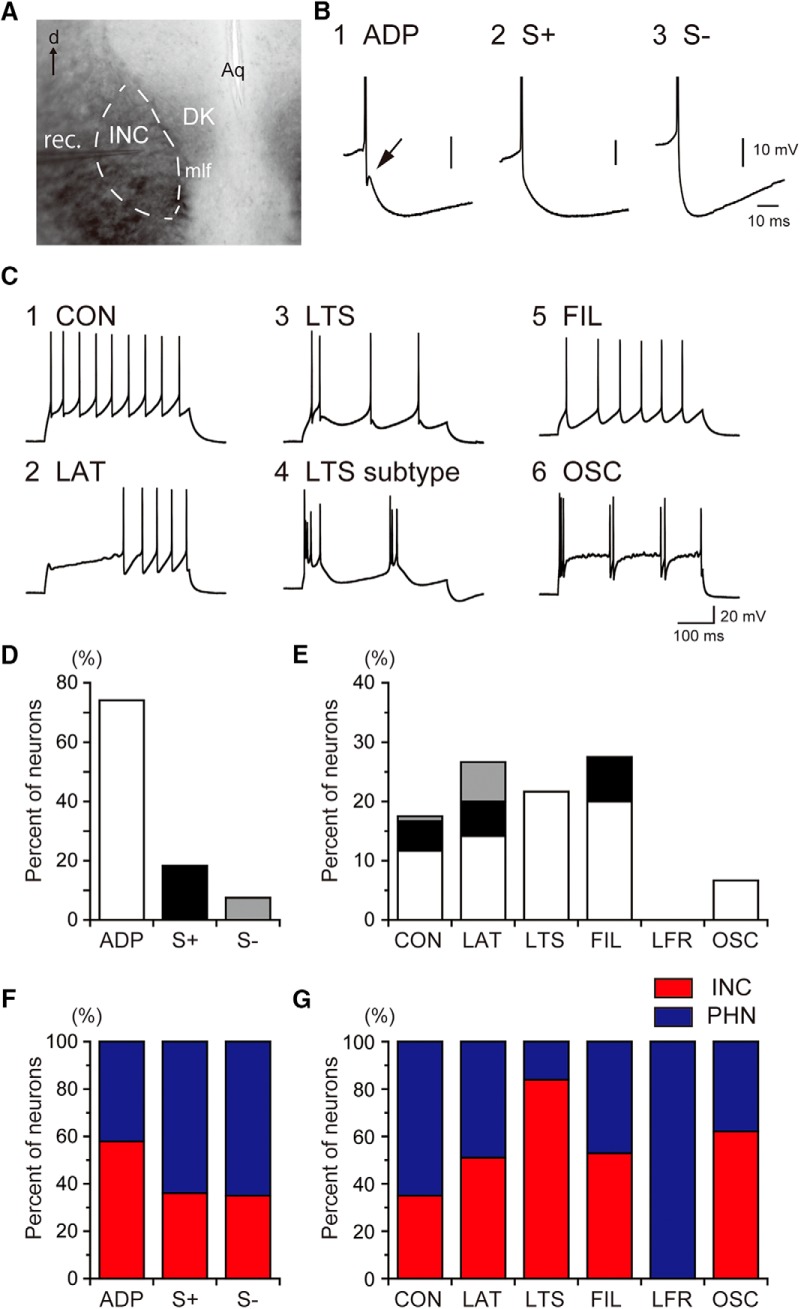

AHP profiles and firing patterns of INC neurons. A, Photomicrograph of a frontal section of the INC. The dashed line shows the rough boundary of the INC. DK, nucleus of Darkschewitsch; mlf, medial longitudinal fasciculus; Aq, aqueduct; rec, recording pipette; d, dorsal. B, AHP profiles. (1) AHP with ADP (arrow), (2) AHP with a slow component (S+), and (3) AHP without a slow component (S-). C, firing patterns. (1) Continuous spiking pattern (CON), (2) late spiking pattern (LAT), (3) low-threshold calcium spike pattern (LTS), (4) a subtype of LTS that exhibited oscillatory burst firing, (5) longer first interspike interval pattern (FIL), and (6) oscillatory firing pattern (OSC). The white, black and gray bars represent the ADP, S+ and S- profiles, respectively. D, E, distributions of the AHP profiles (D) and the firing patterns (E) among INC neurons. F, G, The proportion of INC (red) and PHN (blue) neurons that exhibited each AHP profile (F) or firing pattern (G). The percentages of neurons that exhibited each AHP profile or each firing pattern was normalized to the total percentages of neurons exhibiting each property.